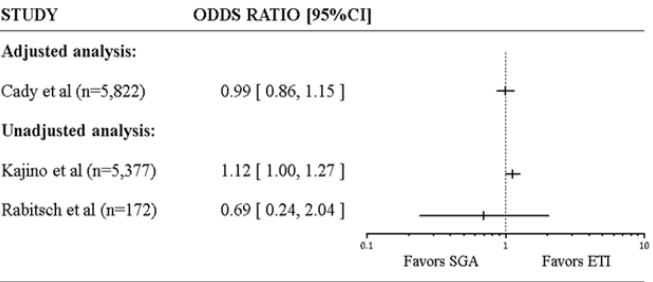
Figure 2b. Associations of pre-hospital advanced airways [endotracheal intubation (ETI) versus supraglottic airways (SGA)] with survival to hospital admission.